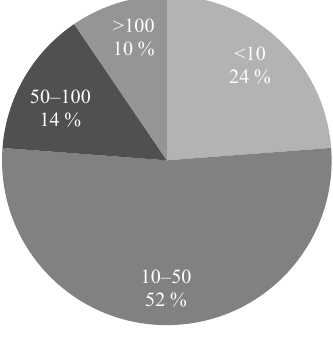
Fig. 1. Share of respondents by the number of employees in their